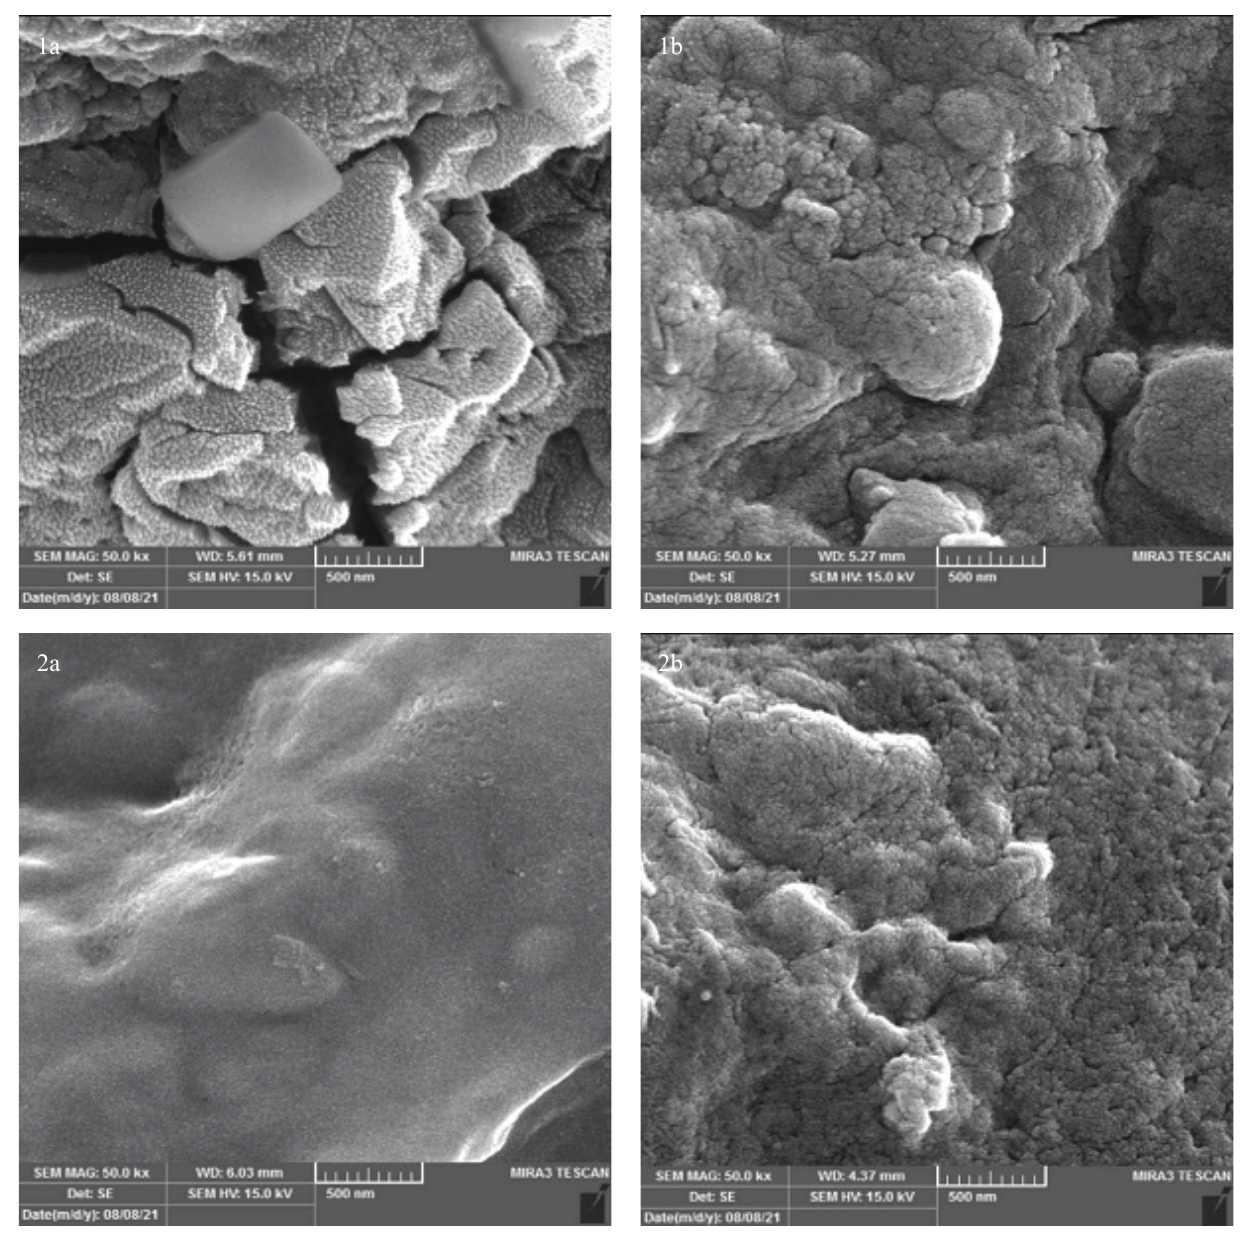
Fig. 6 – SEM images; panel 1 for SA beads, panel 2 for Sa-PVA beads, a and b represent before and after SDS biodegradation,